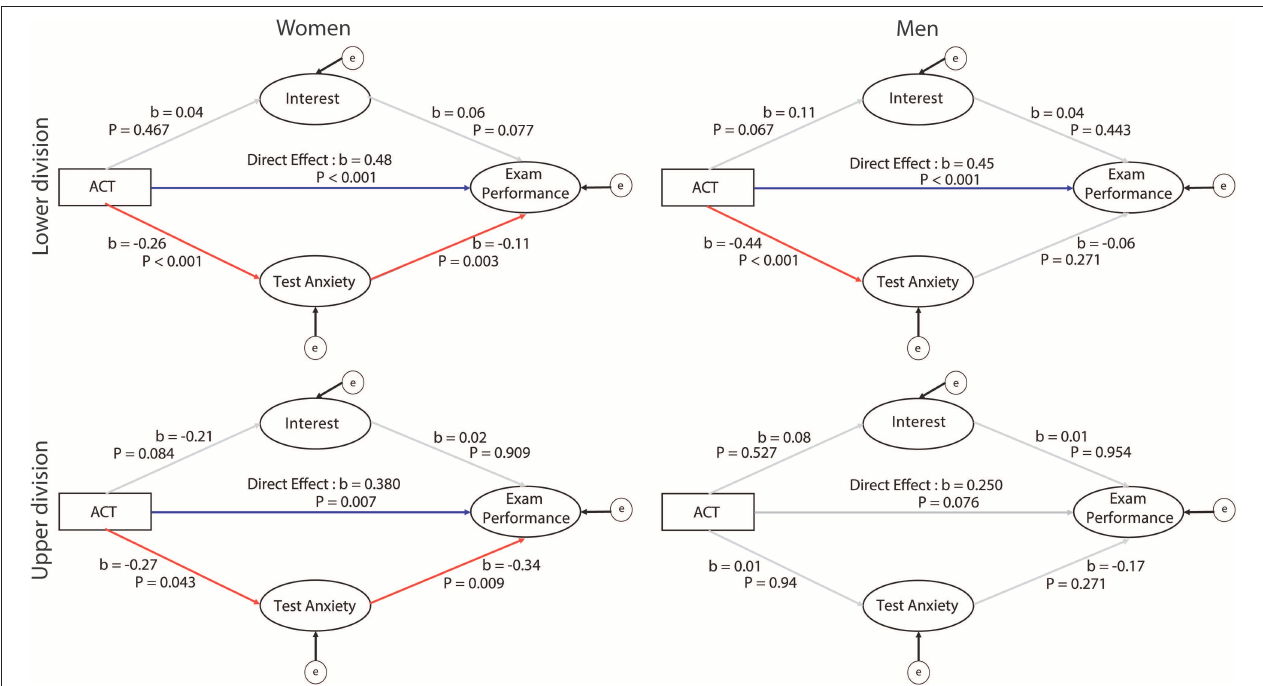
FIGURE 3 | Partial mediation analyses show differences in the significant effects of incoming preparation (ACT) on exam performance for female (Left) and male (Right) students in lower division and upper division courses in the College of Biological Sciences (CBS). Red arrows depict negative effects and blue arrows show positive effects. ACT has direct, positive effects on exam performance for all lower division students and for female upper division students. This effect was marginally significant for male upper division students. For female students in the lower and upper division courses, ACT negatively predicts test anxiety, which in turn influences exam performance. For male students at the lower and upper division, ACT negatively affects test anxiety, but test anxiety does not in turn influence exam performance. In the graphs, “e” circles indicate error terms in estimations of the structural equation model